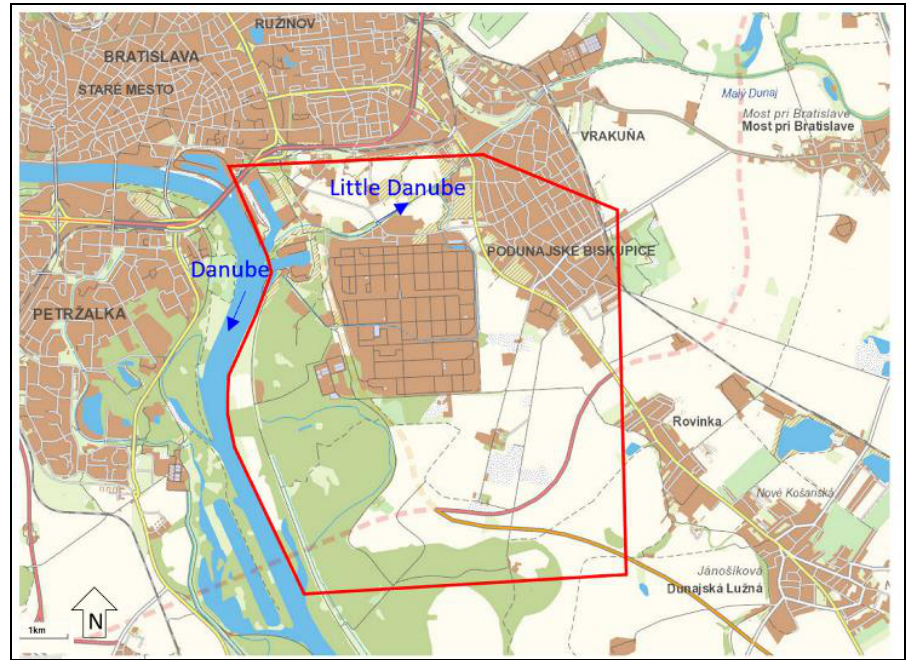
Figure 1. Location of the model domain in Bratislava, Slovakia, near the Danube River.